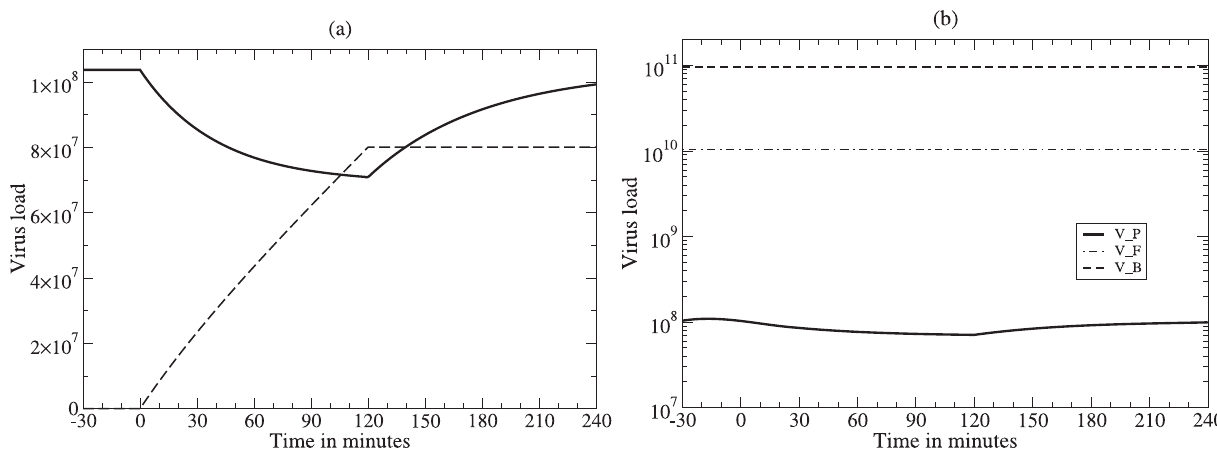
Figure 2. Plasma apheresis for 2 hrs simulated in the model for a patient with V P ^ 10 8 , V F ^ 10 10 and V B ^ 10 11 virus particles in the total body. The solid line is the plasma viral load ( V P ). The discontinuities reflect the time period of plasma apheresis which starts at time zero and continues for two hours (during this period we set E ~ 12 d { 1 ; otherwise E ~ 0 ). The dashed line in (a) is the total amount of virus removed ( V R ), i.e., the solution of d V R = d t ~ E V P . The dashed line in (b) is virus bound to FDCs ( V B ), and the dash-dotted line in (b) is free virus in lymphoid tissue ( V F